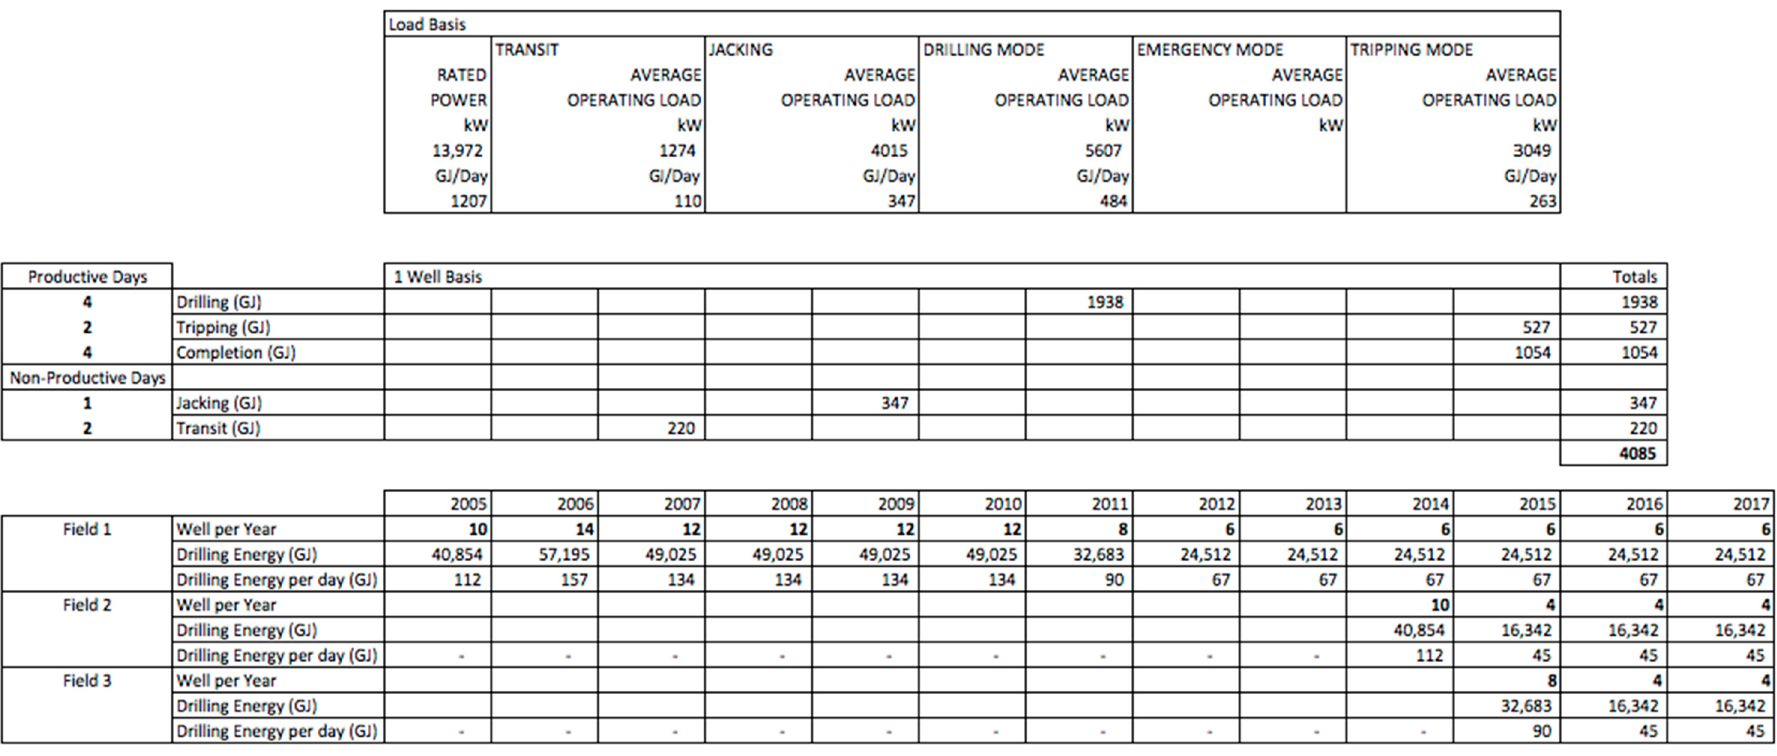
Figure A1. Drilling Energy Calculation.